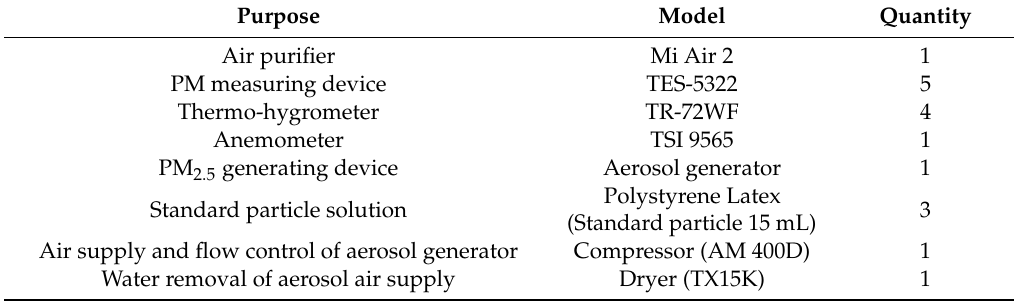
Figure 1. Experimental space and location of experiment equipment. ( a ) Experimental space; ( b ) Location of experiment equipment. Table 1. Equipment and materials for experiment.